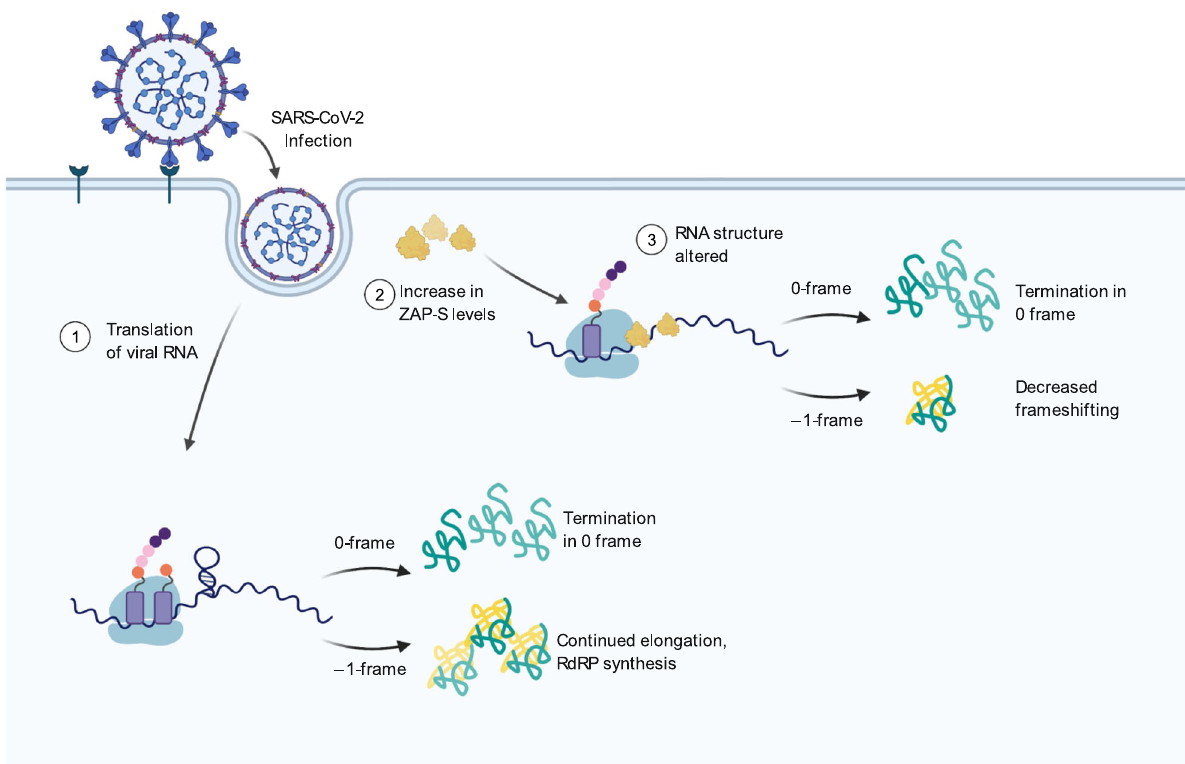
Fig. 6 Model for ZAP-S mediated inhibition of SARS-CoV-2 frameshifting. 1 Upon infection, the viral RNA is translated by the cellular machinery,